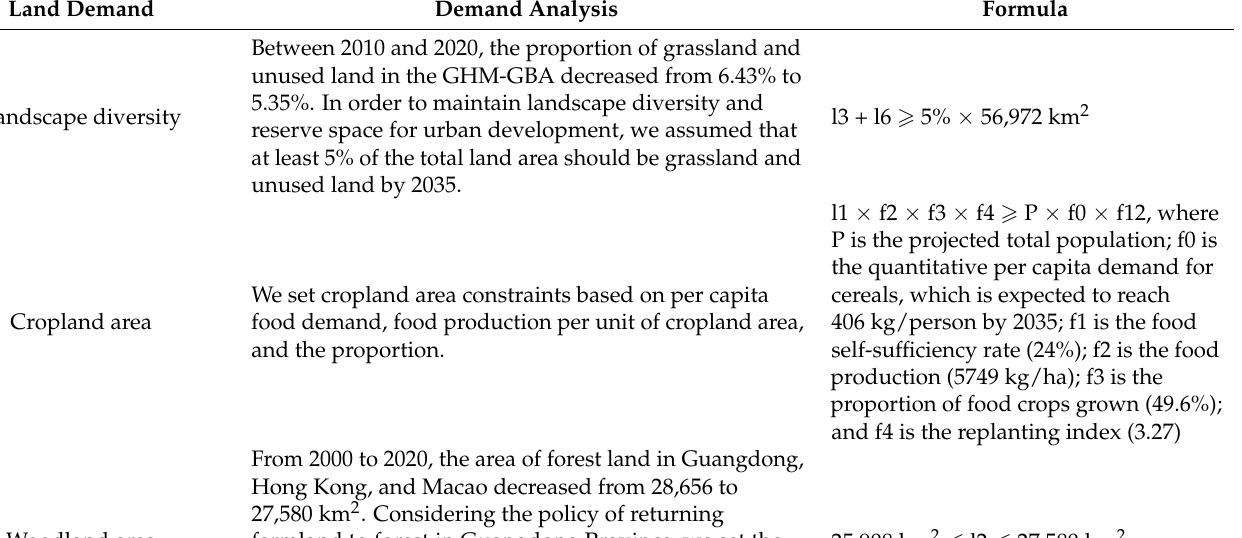
Table 3. Land demand and